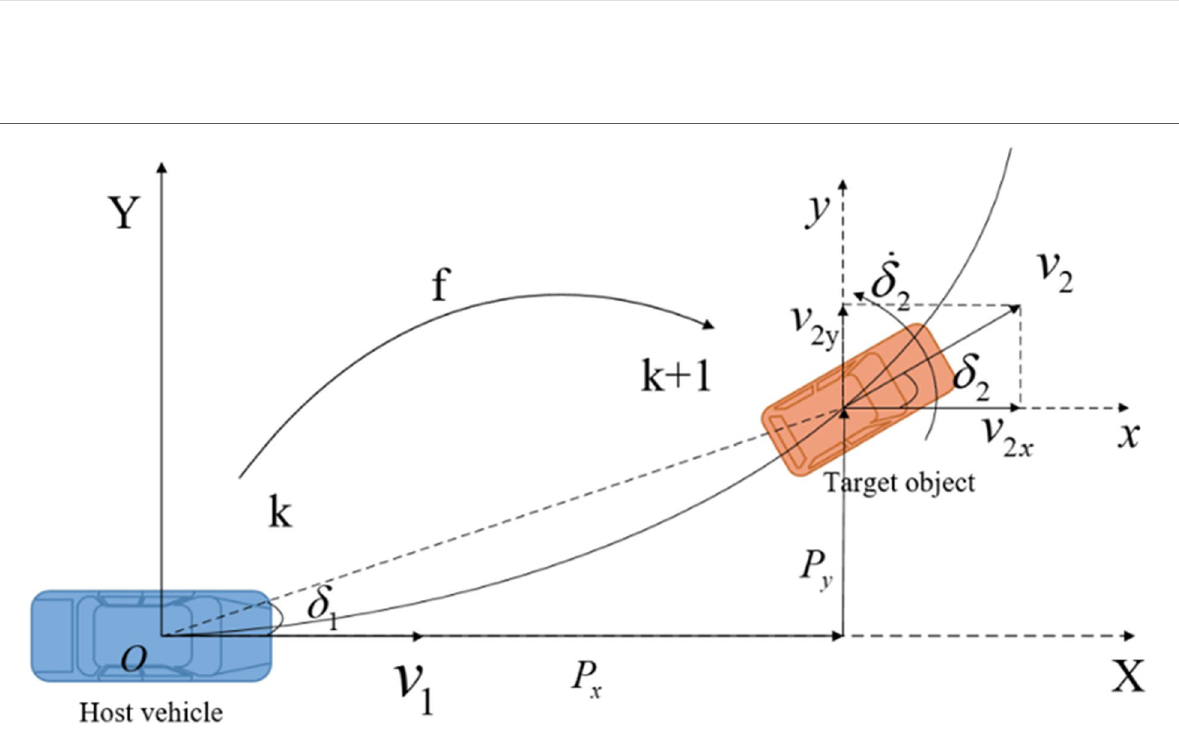
Figure 4 Moving object